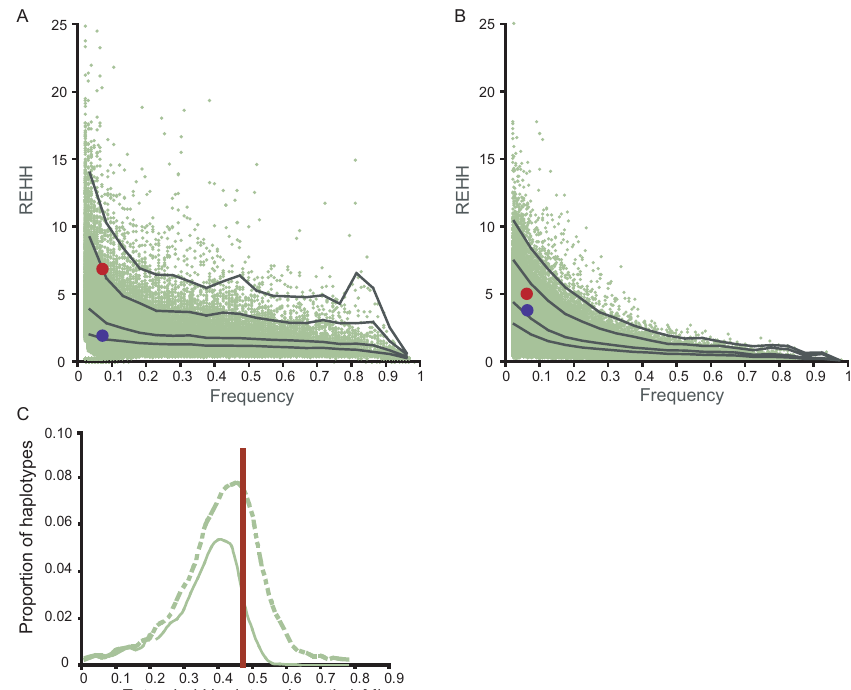
Figure 3. Comparisons with Empirical and Simulation Data (A) and (B) Plots of relative EHH versus frequency for CCR5 in comparison to HapMap data (release 16) for Chromosome 3 in European-Americans (A) and 1,000 simulations of 400 chromosomes in European-Americans (B). Green dots represent the comparison haplotypes and the lines represent, from bottom to top, the 50th, 75th, 95th, and 99th percentiles. The red dots represent the results for eight CCR5- D 32 -bearing chromosomes in (A) and 32 CCR5- D 32 -bearing chromosomes in (B) for the centromere-proximal side, and the blue dots represent results for the centromere-distal side. (C) EHL of the haplotypes of frequency 6%–10% from the HapMap (solid green line) and from simulations (dotted green line) in comparison to CCR5- D 32 (red line). DOI: